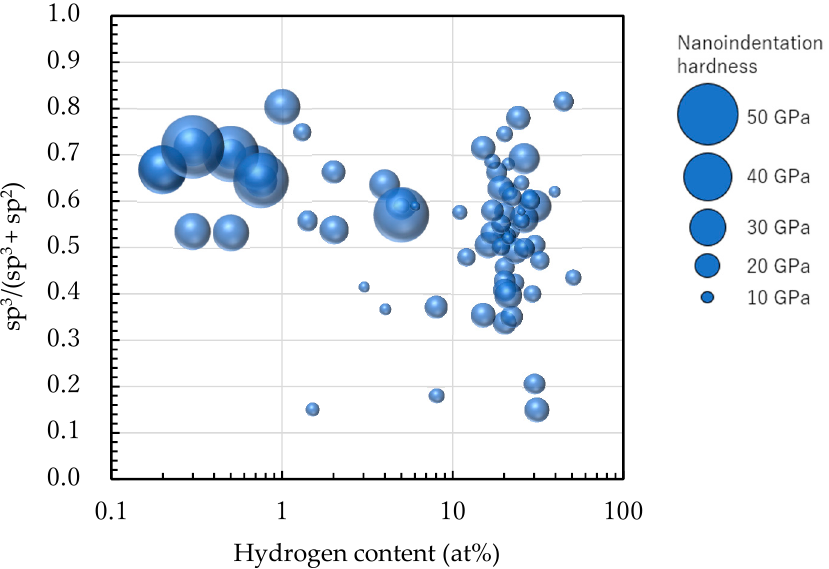
Figure 10. Distribution of 74 types of amorphous carbon films on the sp 3 ratio–logarithmic hydrogen content plane. The diameter of the circle corresponds to the nanoindentation hardness of each amorphous carbon film.